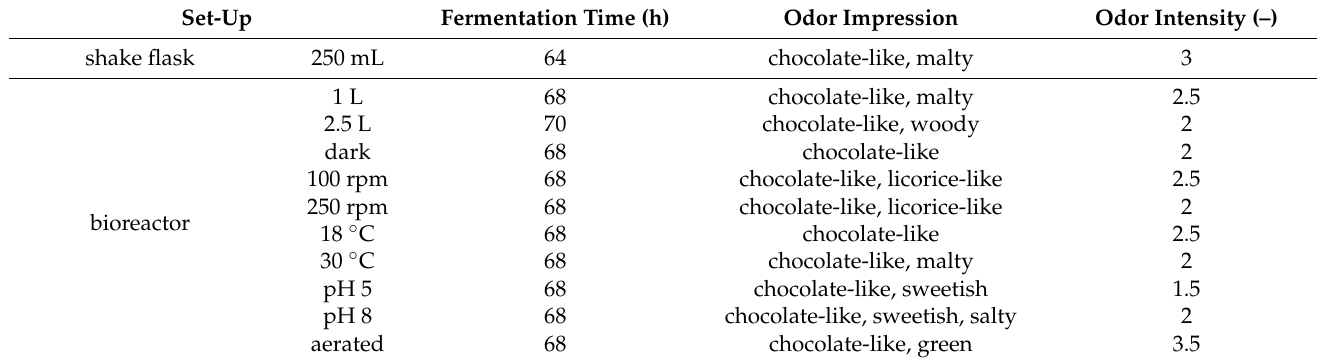
Table 1. Sensory evaluation of fermented green tea broth produced in different fermentation